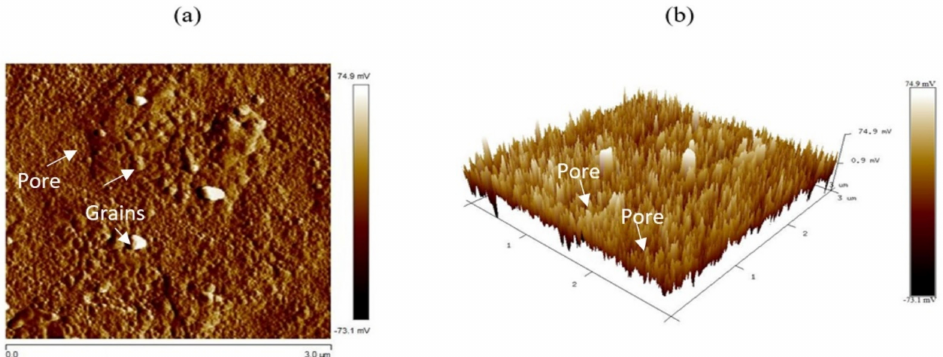
Figure 3. AFM images of the synthesized NiO films: ( a ) 2D, ( b ) 3D